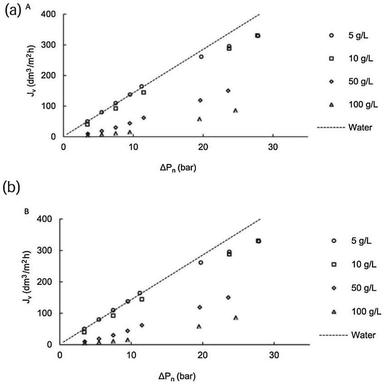
Permeate flux (JV) for water and glucose solutions 95, 10, 50 and 100 g/L) through (a) DK and (b) DL membranes .